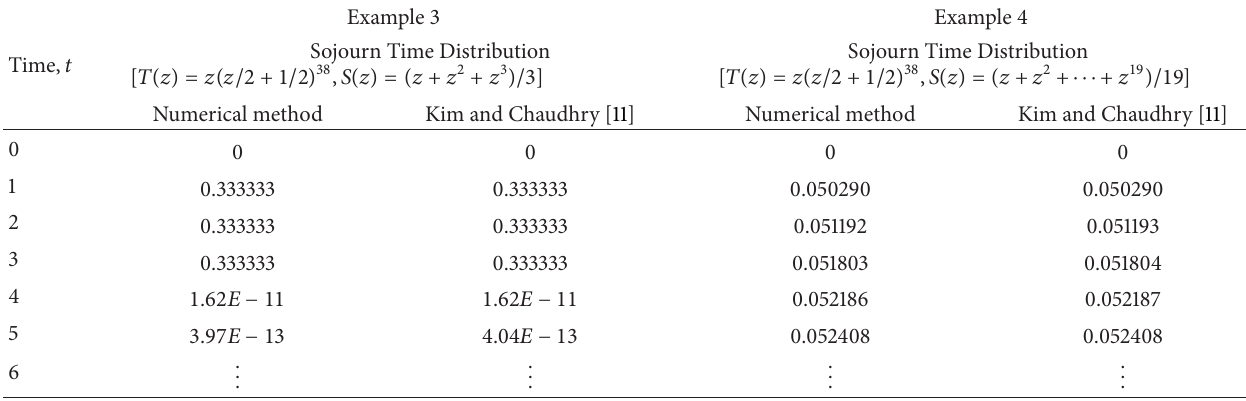
Table 9: Comparison of stationary sojourn time distributions computed using the proposed numerical method and that given in Kim and Chaudhry [11] ( Δ𝑡 =